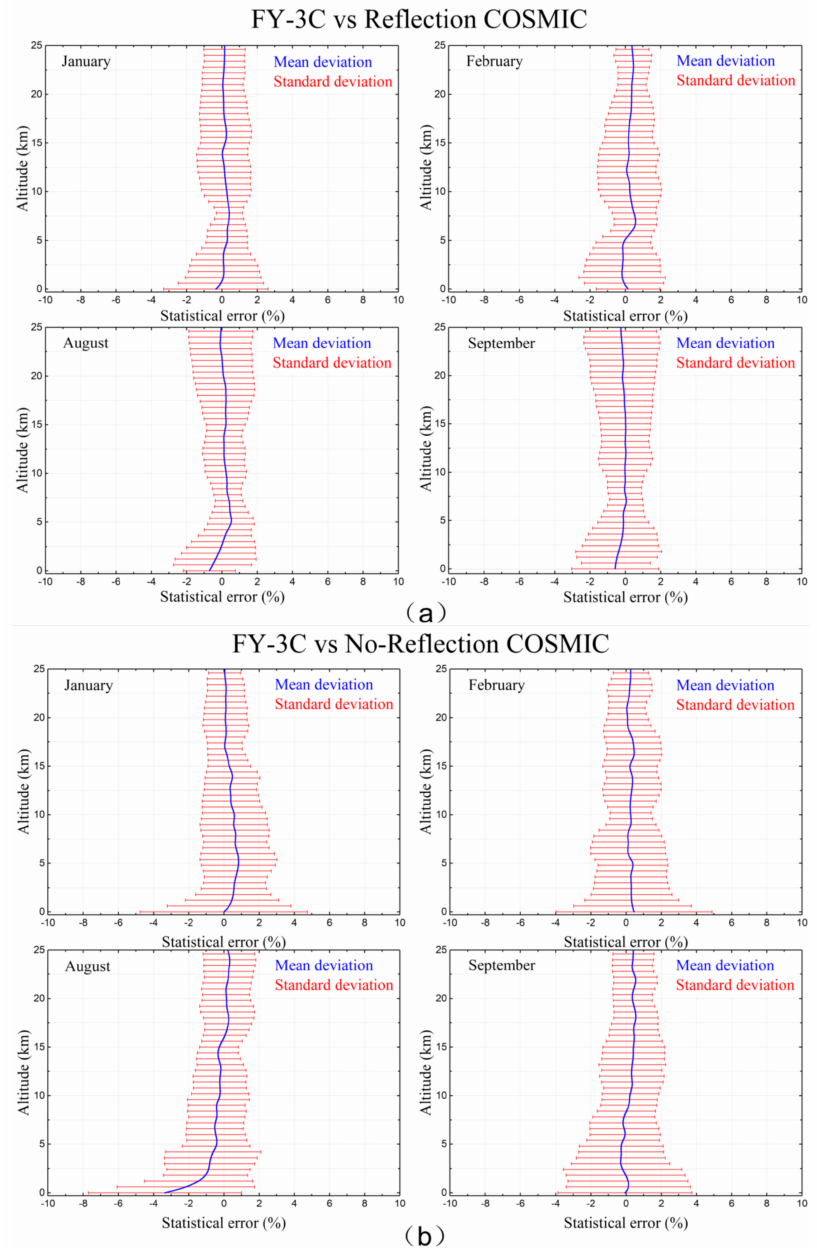
Figure 3. ( a ) Refractivity deviation from matched profiles of FY-3C and COSMIC events with presence of reflected signals. ( b ) Refractivity deviation from matched profiles of FY-3C and COSMIC events without presence of reflected signals. Each panel from left to right and from top to bottom shows the mean bias (blue) and standard deviation (red) of one selected